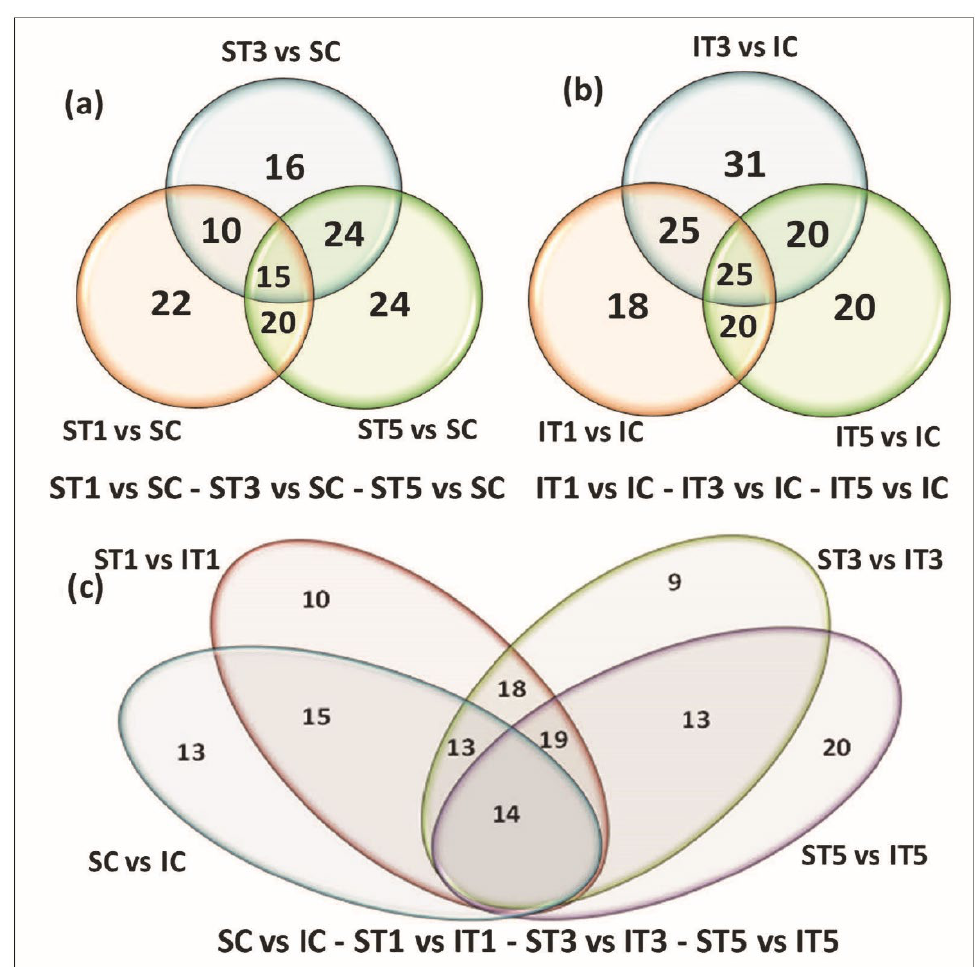
Figure 4. Venn diagram of differentially expressed miRNAs between different comparisons of tol- erant (Swarnaprabha (S)) and susceptible (IR8 (I)) rice genotypes. The sum of numbers in each circle represents a total number of differentially expressed miRNAs within a group, while overlap repre- sents the miRNAs expressed commonly in between comparisons. ( a ) Distribution of differentially expressed miRNA between ST1, ST3, and ST5 with respect to control ( b ) Distribution of differen- tially expressed miRNA between IT1, IT3, and IT5 with respect to control ( c ) Distribution of differ- entially expressed miRNA between SC, ST1, ST3, ST5 and IC, IT1, IT3, IT5. IC-IR8 control (un- treated); IT1-IR8 for 1 day low-light-treated; IT3-IR8 for 3 days low-light-treated; IT5-IR8 for 5 days low-light-treated; SC—Swarnaprabha control (untreated); ST1—Swarnaprabha for 1 day low-light- treated; ST3—Swarnaprabha for 3 days low-light-treated; ST5—Swarnaprabha for 5 days low-light- treated.